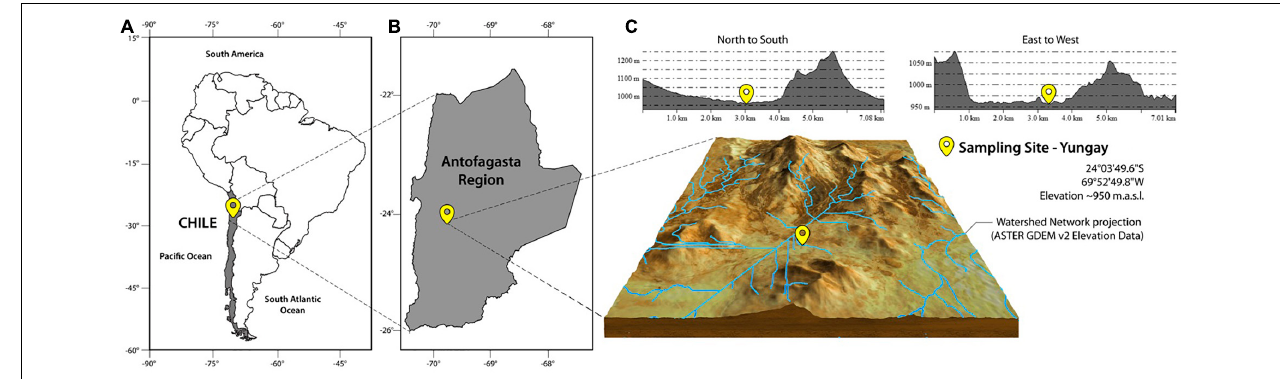
FIGURE 1 | Location of the study site in Yungay, in the hyperarid core, Atacama Desert. (A) Chile, (B) Antofagasta Region, (C) Yungay in the hyperarid core.